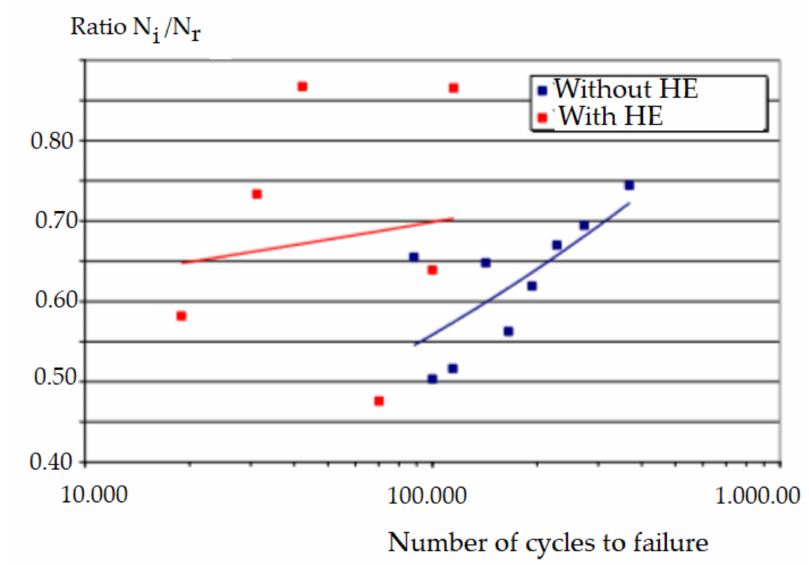
Figure 6. N i / N r ratio versus the number of failure cycles for API 5L X52 steel [11]. Table 1. Fatigue initiation resistance and exponent β for API 5L X52 steel